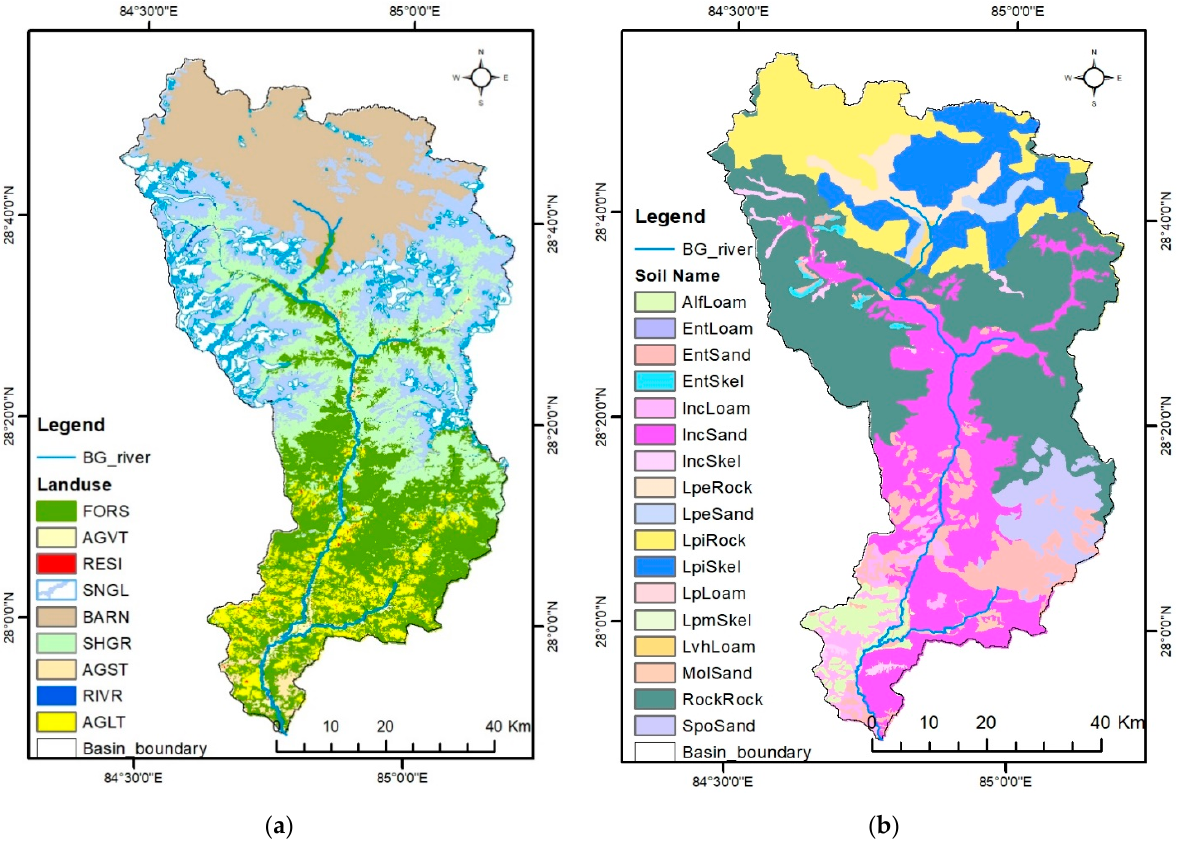
Figure 2. ( a ) Landuse and Land Cover, ( b ) Soil Map.